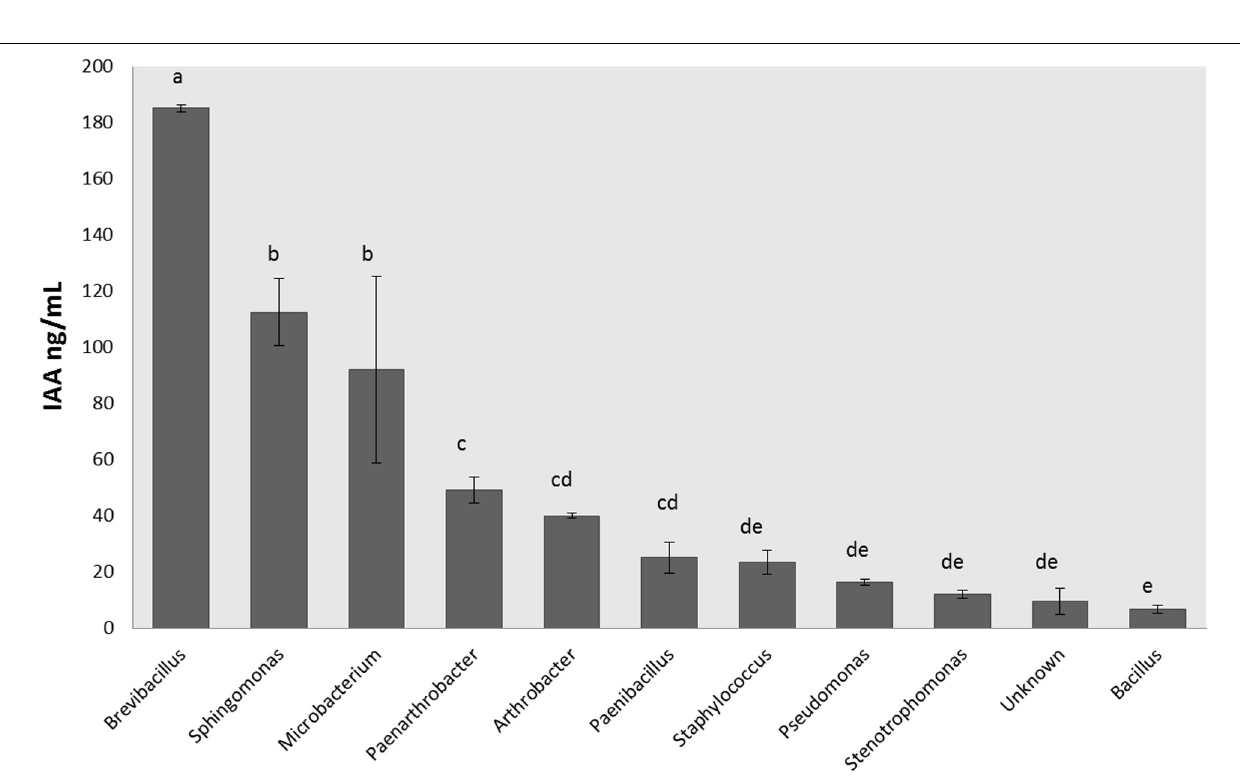
Frontiers in Plant Science |